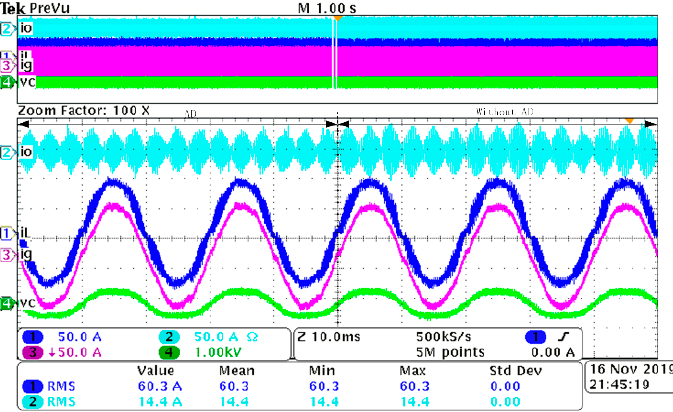
Figure 17. Waveform comparison of i o , i L , i g , and v c between AD and without AD under 60A i L.